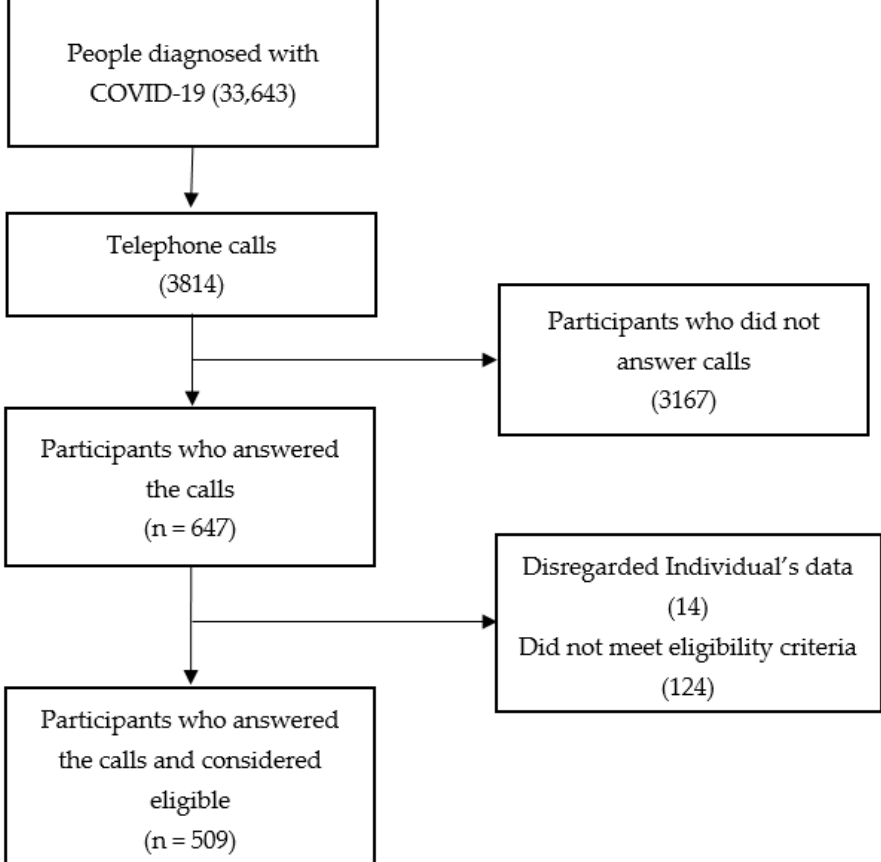
Figure 1. Flowchart of study design. Patients with coronavirus disease (COVID-19). The figure represents a flow diagram of the study.